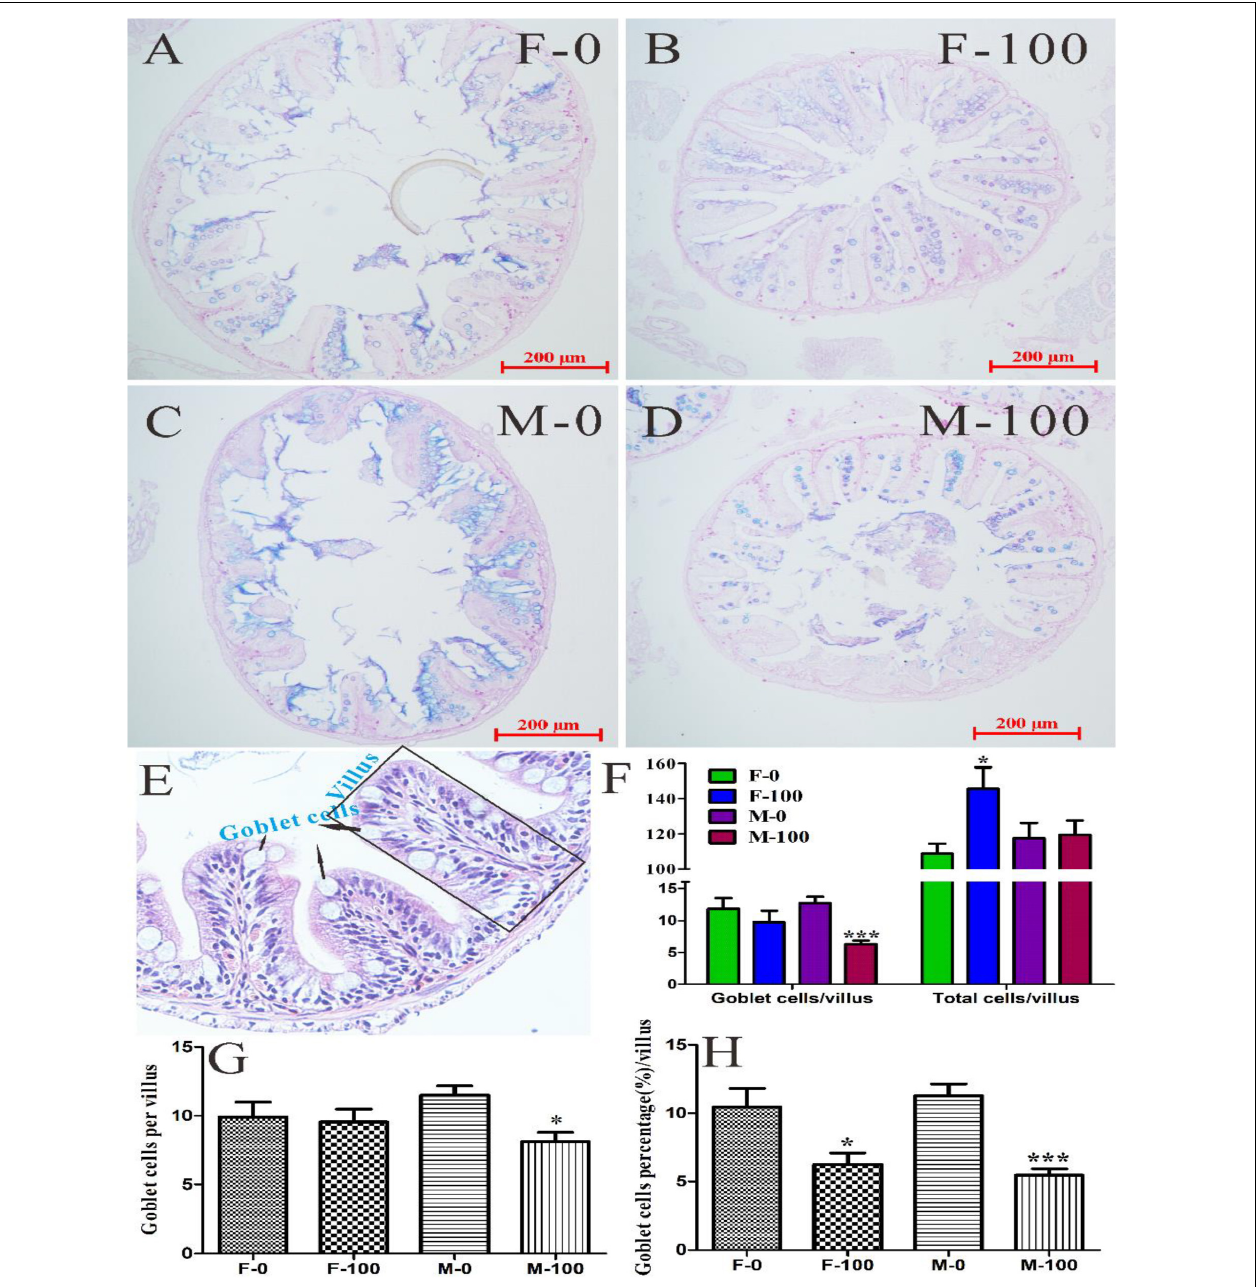
FIGURE 5 | The goblet cells in zebrafish intestine tissues with AB-PAS and H&E stain. The histological analysis of gut tissue in female (A) and male (C) zebrafish in the control group, female (B) and male (D) zebrafish in the 100 µ g/L DEHP treatment group. From the H&E sections of gut tissues (E) , the goblet cells and total cells of each villus (F) were counted. (G) The number of goblet cells was counted from AB-PAS sections with 200 µ m scale bar and 200 × images, and (H) the percentages of goblet cells per villus were calculated by comparing total cells in the corresponding villus. There was no difference between females and males in the same group, and the symbol * and *** indicated p < 0.05 and 0.001 as the significant changes compared to